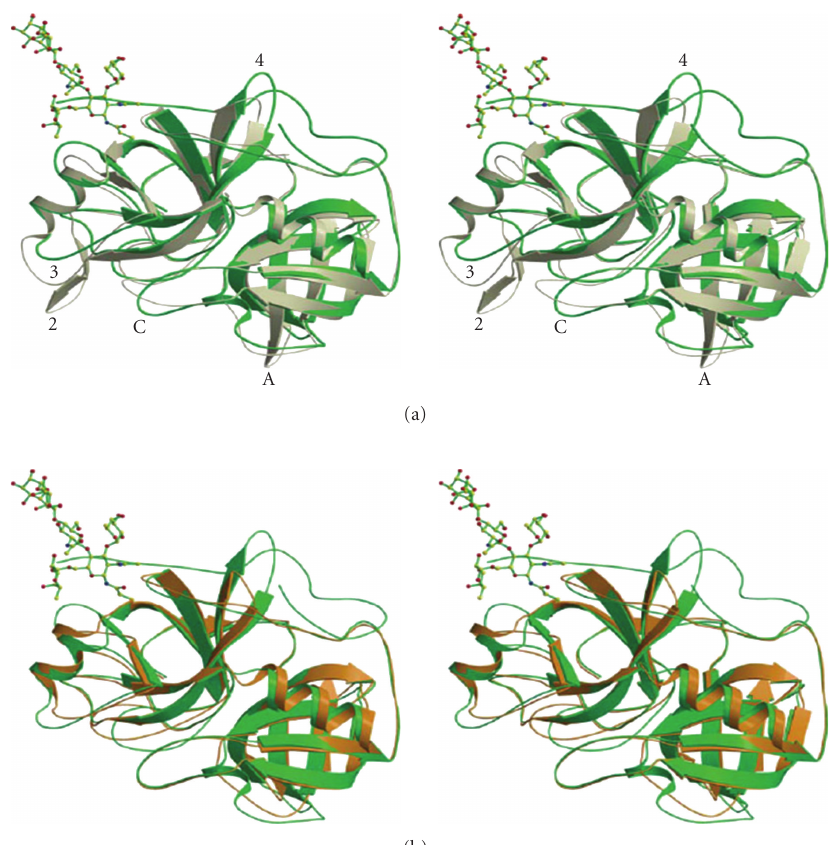
Figure 4: Superposition of EFE-b with EFE-a and trypsin. (a) Stereoview of the superposition of EFE-b with EFE-a is illustrated as follows: EFE-b is represented by green and EFE-a by light goldenrod yellow. The glycan is represented by a ball-and-stick model (carbon atoms, green). Some loops in which EFE-b greatly di ff ers from EFE-a are indicated: loop A (34–41); loop C (97–103); loop 2 (217–225); loop 3 (169–174); loop 4 (201–208). (b) Stereoview of the superposition of EFE-b with trypsin is illustrated as follows: EFE-b is represented by green and trypsin (Protein Data Bank, accession number, 1PPE) by orange. The glycan is represented by a ball-and-stick model (carbon atoms, green) (see [56]).